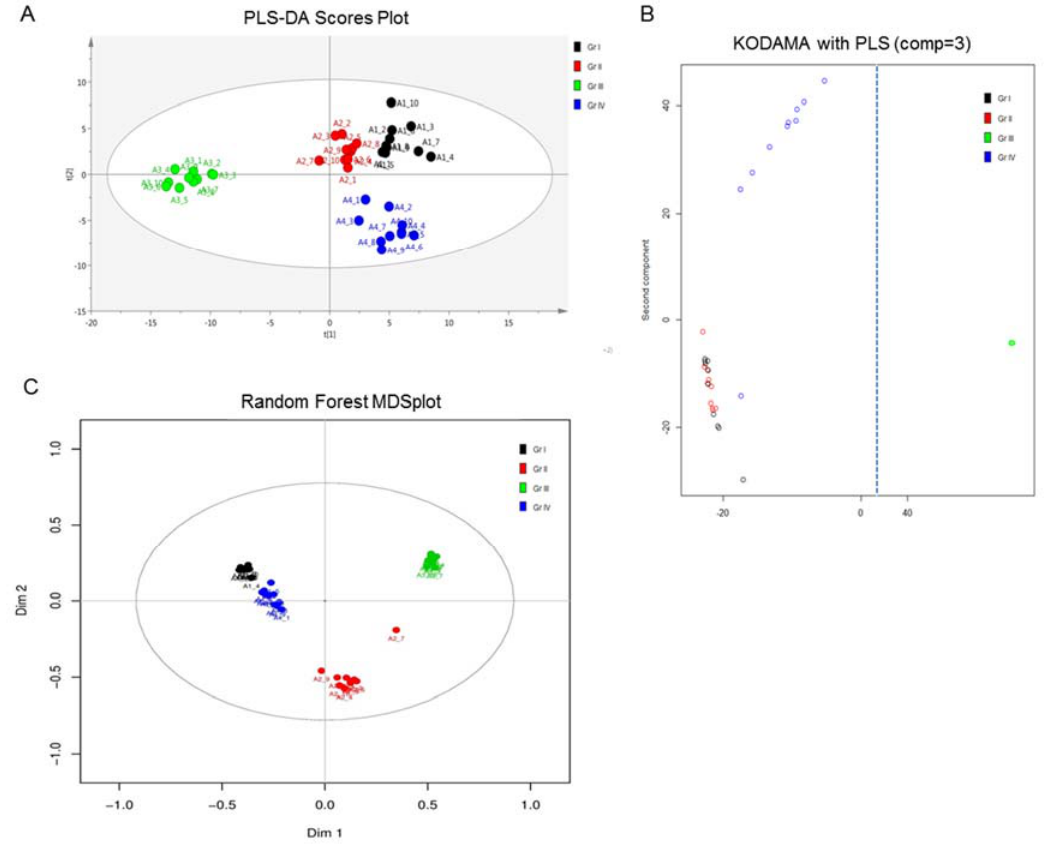
Figure 5. Comparison of the PLS ‐ DA modeling of MS analysis, with KODAMA and Random Forest methods for the four UBC cell lines herein examined. All methods presented the greatest separation for the grade III (T24) group, highlighting T24 as the most suitable cell line to study the metabolic signature of highly malignant and strongly metastatic UBC disease. Black: grade I (RT4), Red: grade II (RT112), Green: grade III (T24), and Blue: grade IV (TCCSUP). ( A ) Principal Component (PC) scores plot from PLS ‐ DA model. ( B ) PC scores plot from the KODAMA ‐ PLS model. Figure is cut on the x ‐ axis (dashed line), as grade III (T24) is far removed from the initial conditions. ( C ) Multidimensional Scaling (MDS) plot from the Random Forest model. Gr: (malignancy) grade.